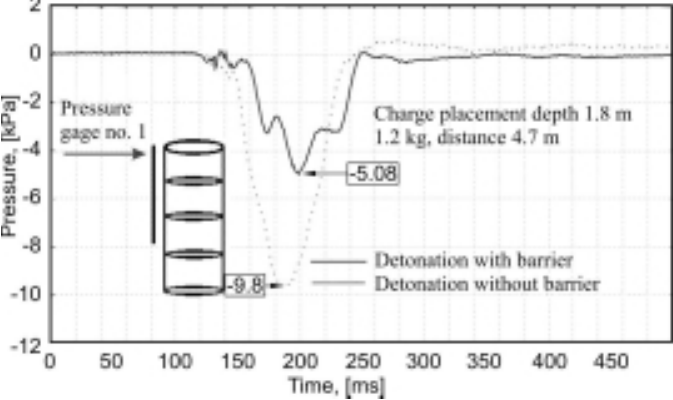
Fig. 12. Time histories of pressures p h on the structure front, measured by gage No. 1 from a detonation at 4.7 m from the silo.